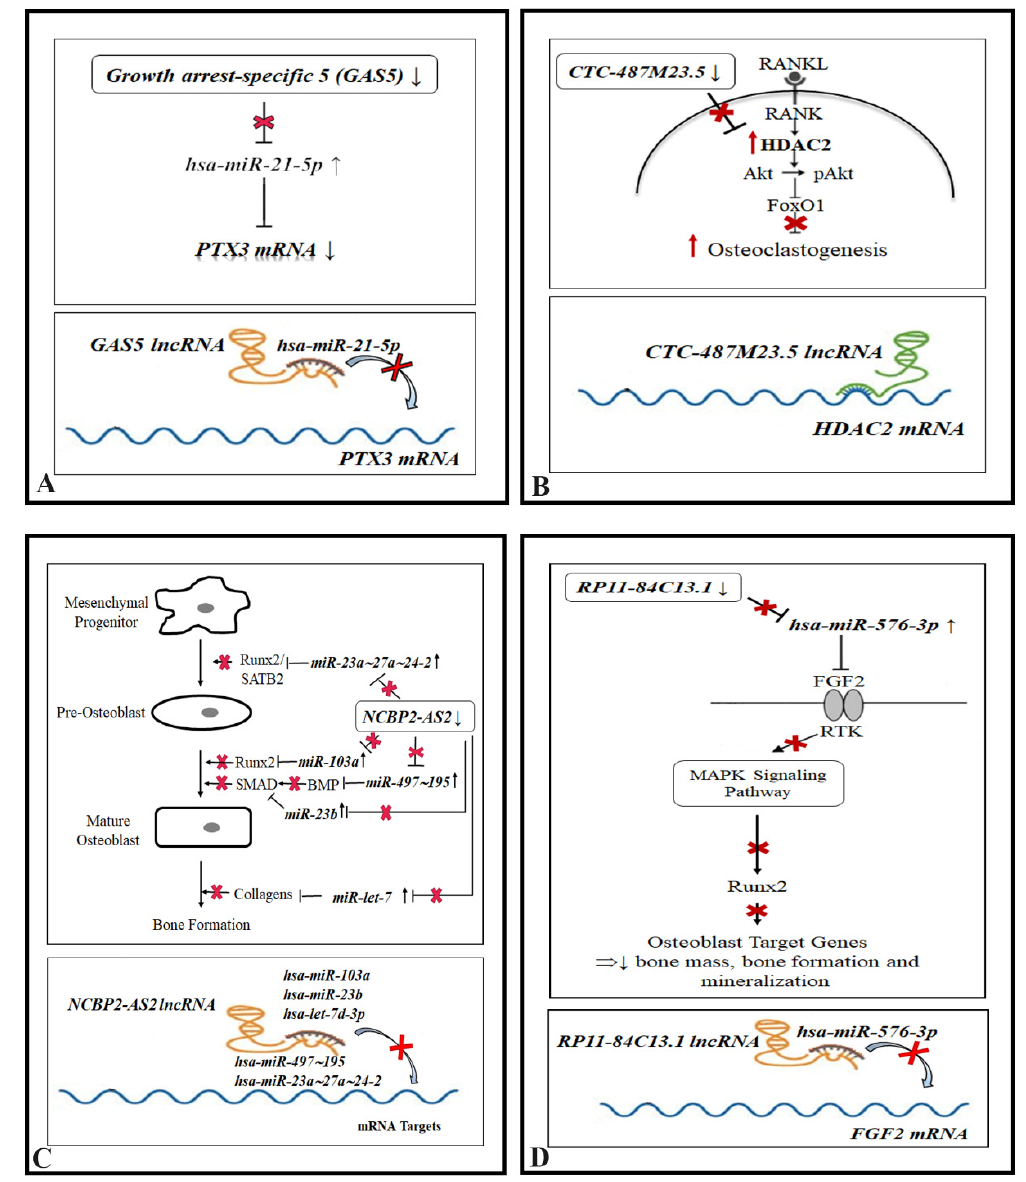
Figure 3. Hypothetical pathogenetic mechanisms emerging from this study. ( A ) Growth arrest-specific 5 ( GAS5 ) lncRNA masks miR-21-5p binding sites, ( B ) CTC-487M23.5 lncRNA inhibits the translation of HDAC2 mRNA, ( C ) NCPB2-AS2 lncRNA masks miRNA binding sites implicated in osteoblast differentiation, and ( D ) RP11-84C13.1 lncRNA masks miR-576-3p binding sites. ↑ and ↑ : increase; ↓: decrease;